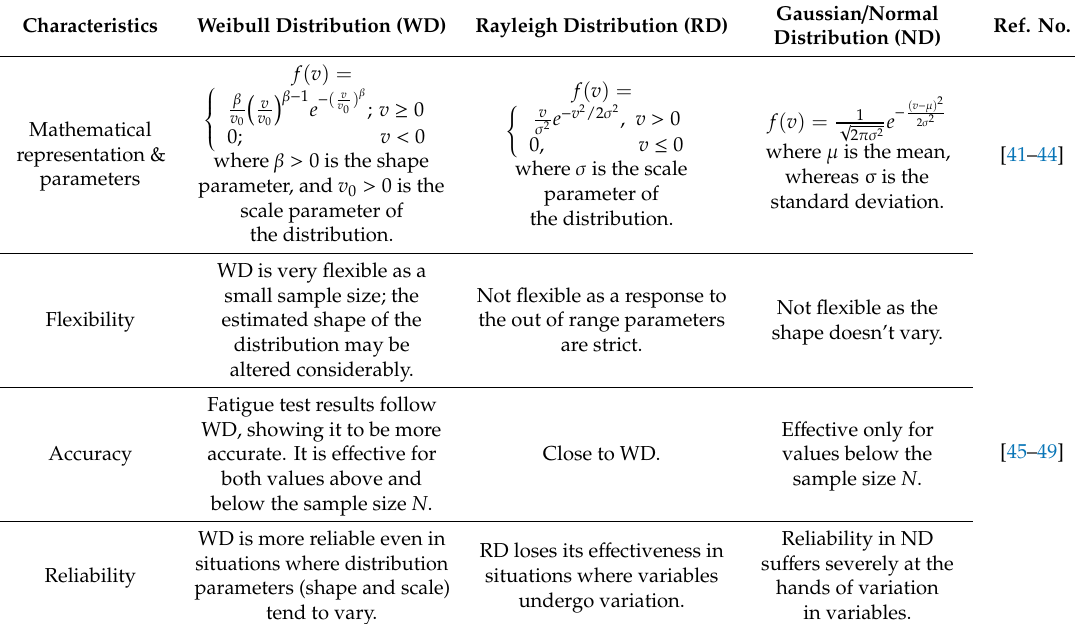
Table 1. Comparison of stochastic forecasting